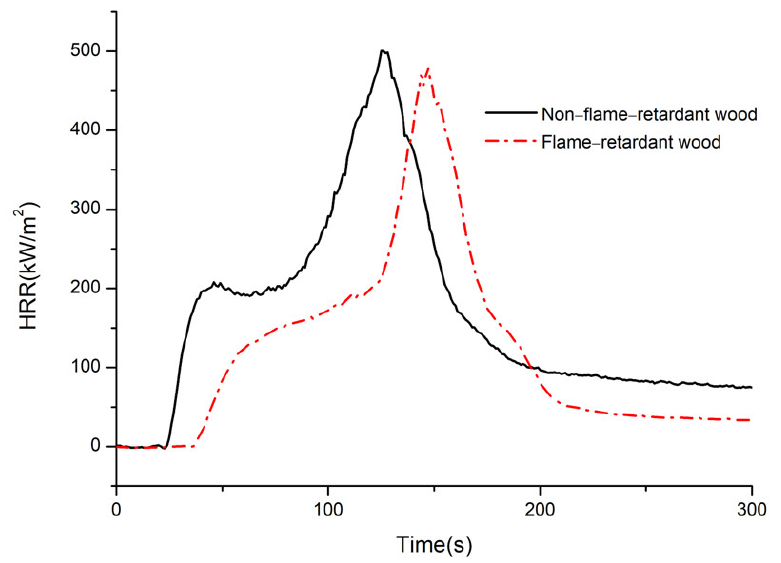
Figure 14. HRR of non-flame retardant bamboo and flame retardant bamboo.